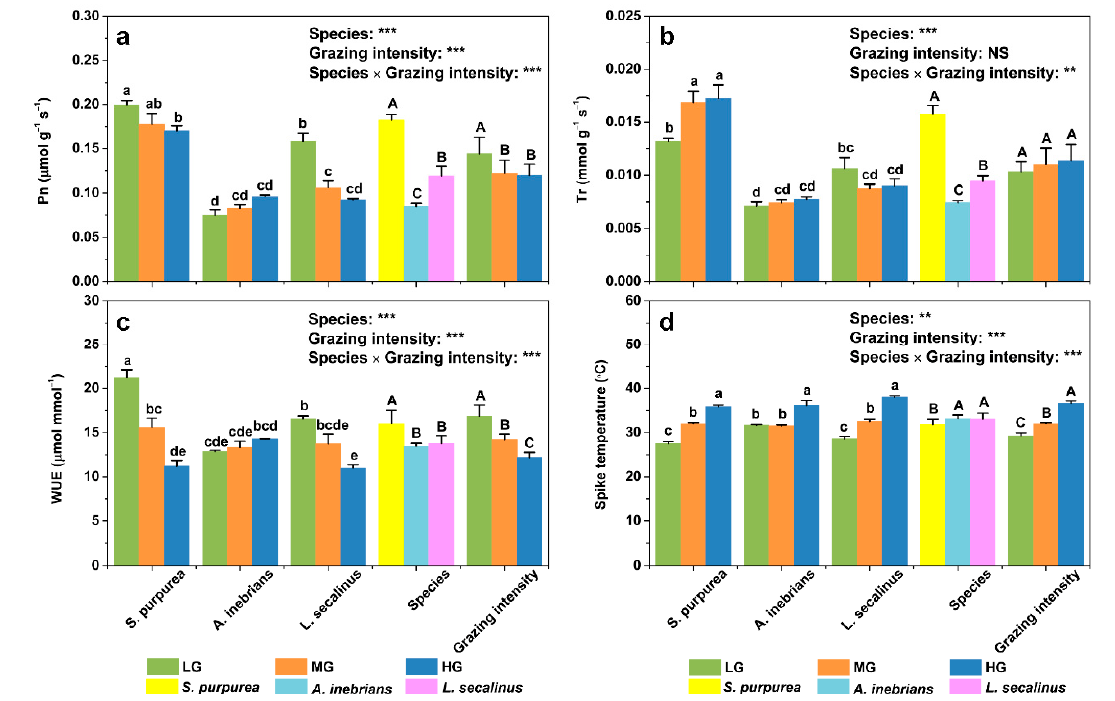
Figure 4. Mean values of photosynthesis parameters including the net photosynthetic rate (Pn) ( a ), transpiration rate (Tr) ( b ), water use efficiency (WUE) ( c ), and spike temperature (T s ) ( d ) of the spikes of S. purpurea , A. inebrians and L. secalinus in response to grazing intensity (LG, light grazing; MG, medium grazing; HG, heavy grazing). Note: S. purpurea , Stipa purpurea ; A. inebrians , Achnatherum inebrians ; L. secalinus , Leymus secalinus . The data are presented as mean ± standard error (SE) of three independent experiments. ** p ≤ 0.01; *** p ≤ 0.001; NS, no significance. Different lowercase letters mean significant difference ( p ≤ 0.05) between same species under different grazing intensities. Different uppercase letters mean significant difference ( p ≤ 0.05) between different species or different grazing intensities.